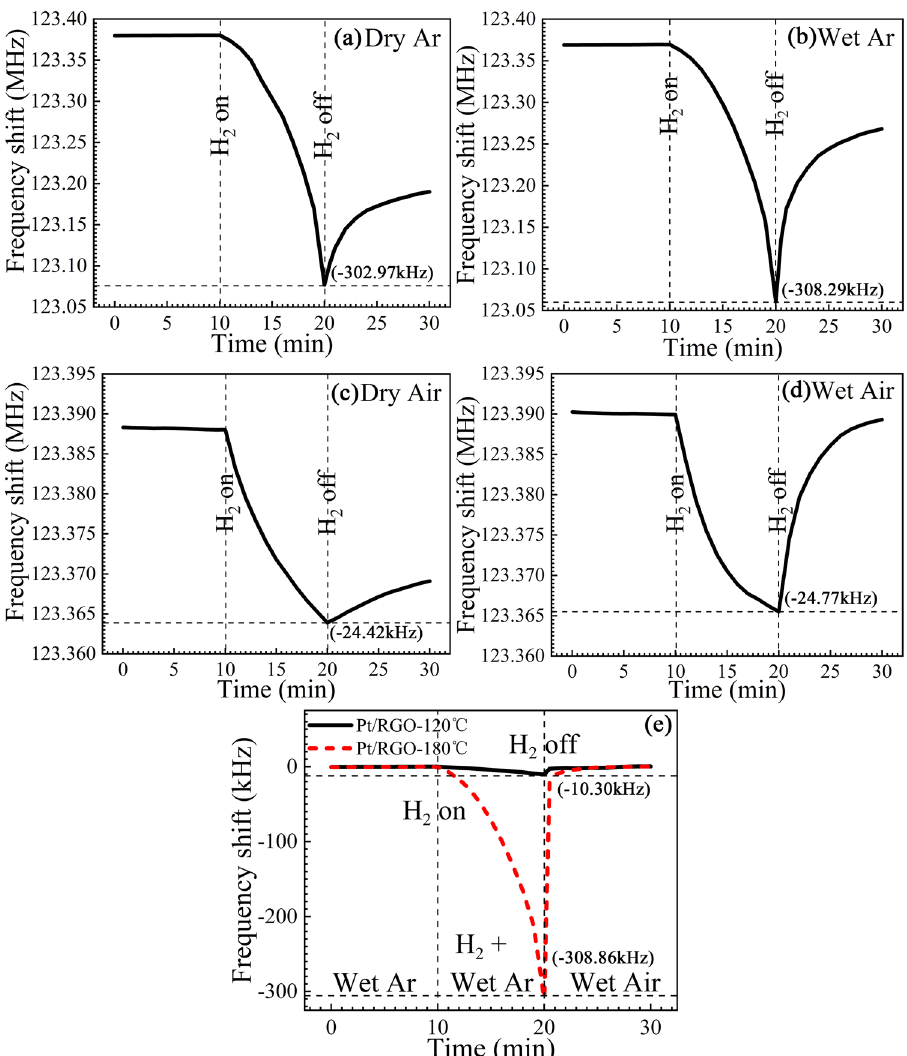
Figure 3. Frequency shift of the sensor towards H 2 . ( a , b ) Shifts of the central frequency of the sensor to 100 ppm H 2 mixed in ( a ) dry argon and ( b ) argon with a relative humidity of 60%. ( c , d ) Shifts of the central frequency of the sensor to 1000 ppm H 2 mixed in ( c ) dry air and ( d ) air with a relative humidity of 60%. ( e ) Shifts of the central frequencies of the sensors with RGO-120 °C and RGO-180 °C sensitive layers to 100 ppm H 2 mixed in argon with a relative humidity of